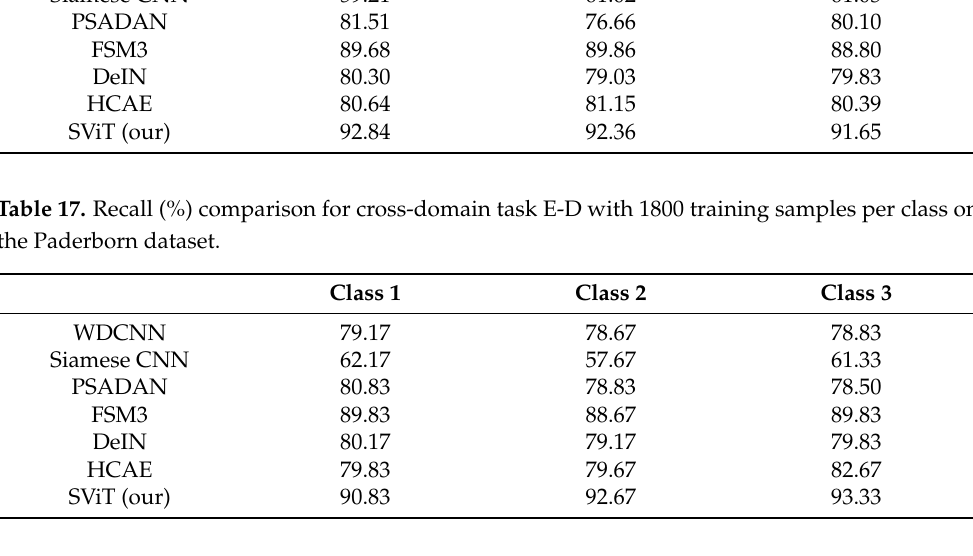
Table 18. F1 score (%) comparison for cross-domain task E-D with 1800 training samples per class on the Paderborn